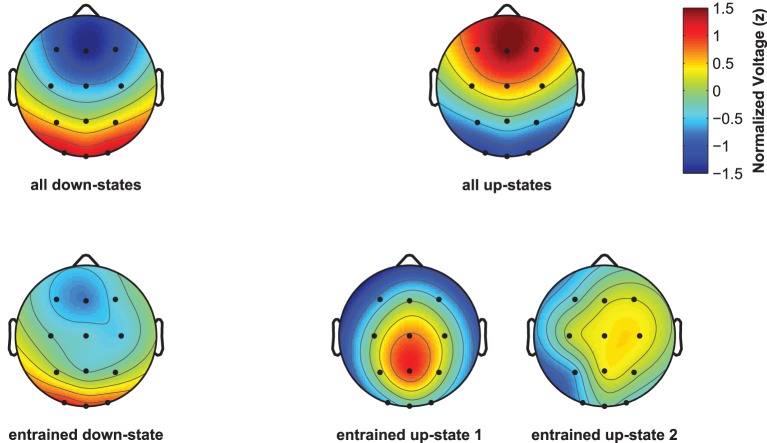
Topographic plots for naturally occurring and entrained down- and up-states. Topographies were normalized within each participant and were then averaged across participants. Plots display the topography at the peak of the ERP for all discretely identified down- and up-states (top line, left and right), and of the ERPs reflecting the entrained down-state and entrained up-states 1 and 2 (bottom line, left and right plots).